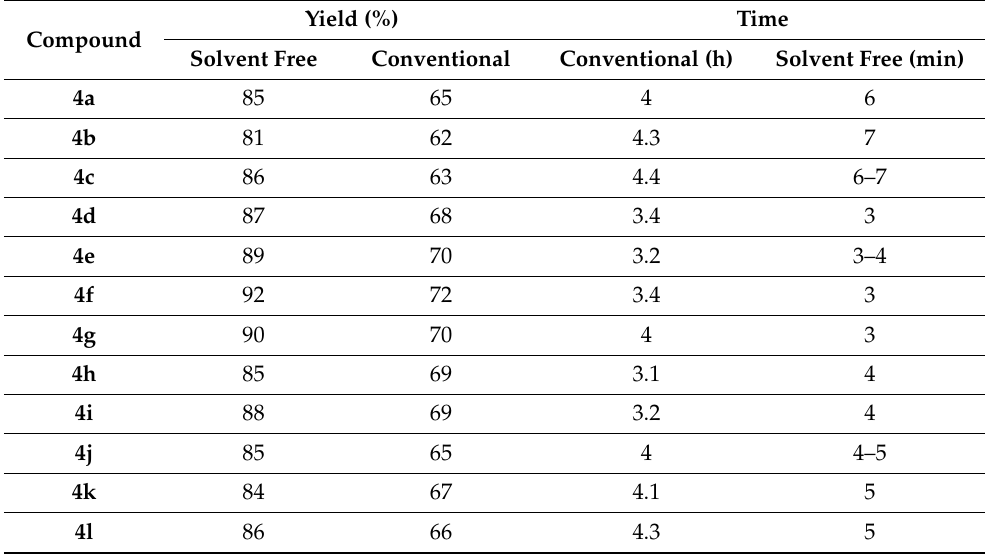
Table 1. Table showing the differences between the conventional and solvent-free methods. Yield (%) Time Compound Solvent Free